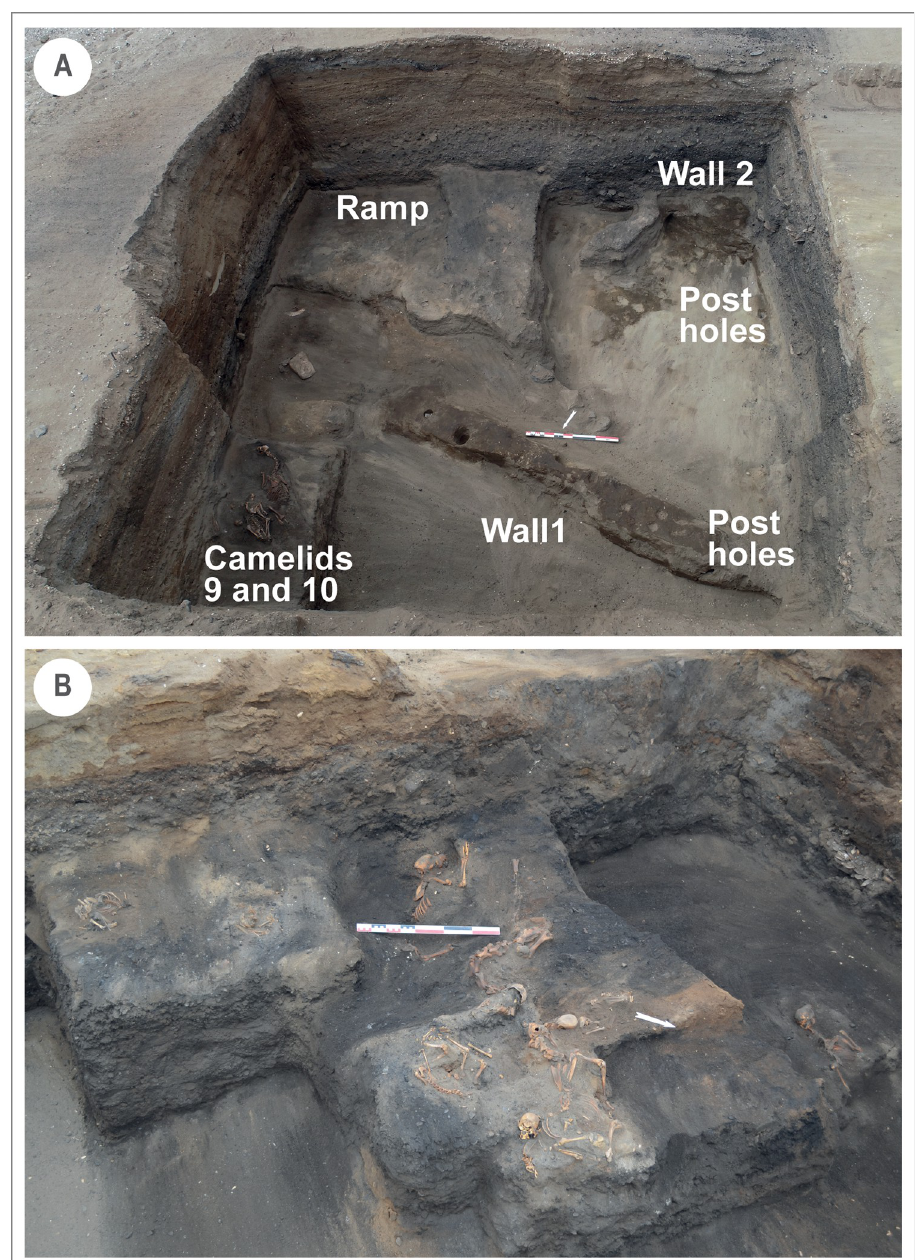
Fig 3. Huaca Grande archaeological features. A. Compact clay structure at the base of the stratigraphic sequence. B. Animal deposit at the top of layer 9.